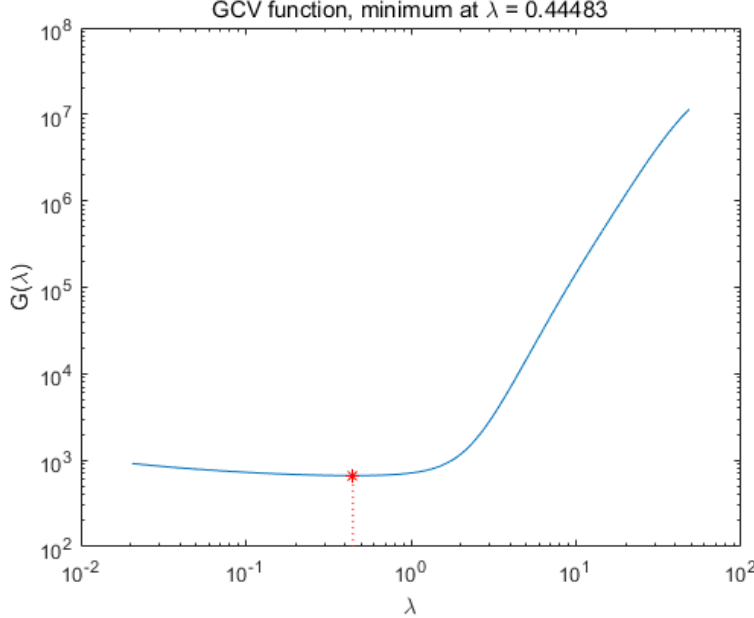
Figure 5. Finding the regularization parameter λ when recovering the best results using the GCV-based Tikhonov method.